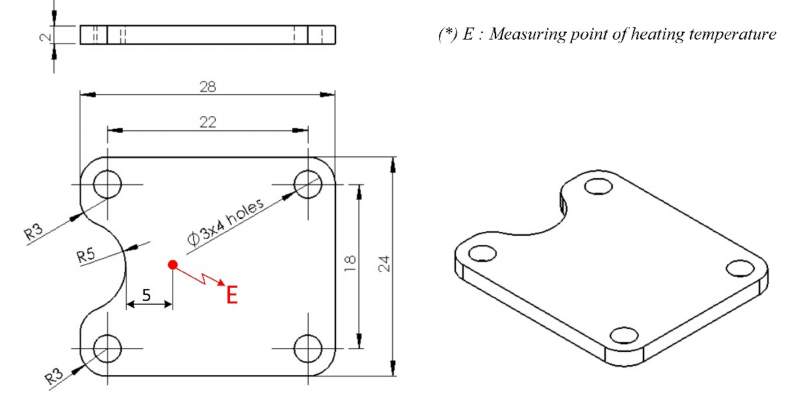
Figure 5. Insert plate used in the heating process.